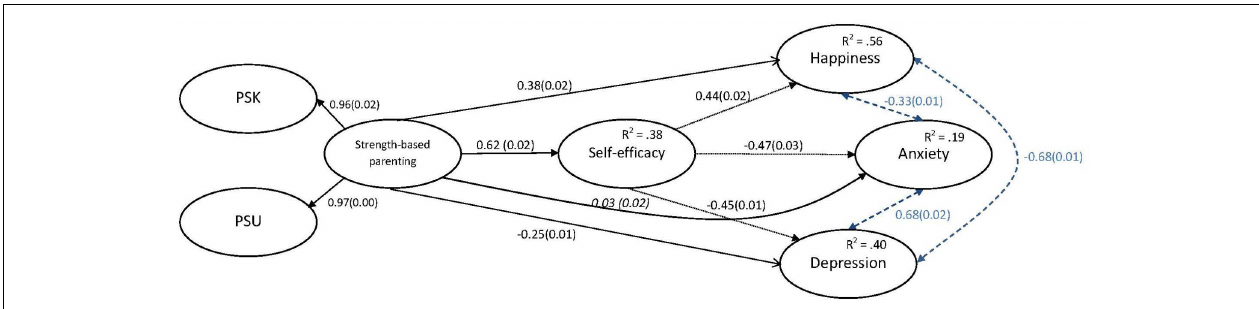
FIGURE 2 | The full mediation model. Values depict standardized β weights, and values in parentheses depict the standard error of β . For convenience indirect effects are denoted by dotted lines and correlations by dashed lines. Non-significant ( p > 0.05) pathways are denoted in italics. Indicators of the latent factors are not displayed for brevity. PSK, parental strength knowledge; PSU, parental strength use.